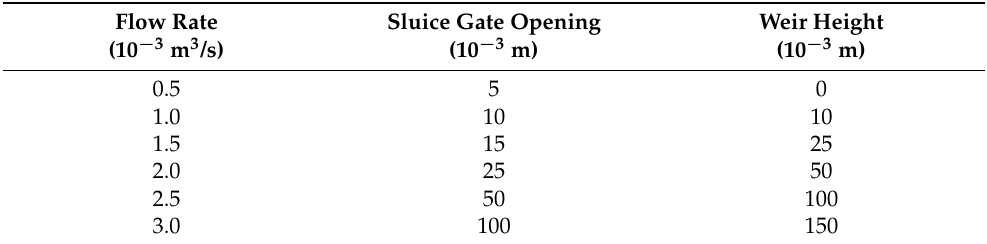
Table 2. The range of target flow rates, sluice gate openings, and weir heights tested in the experiments. Flow Rate Sluice Gate Opening Weir (10 − 3 m 3 /s)